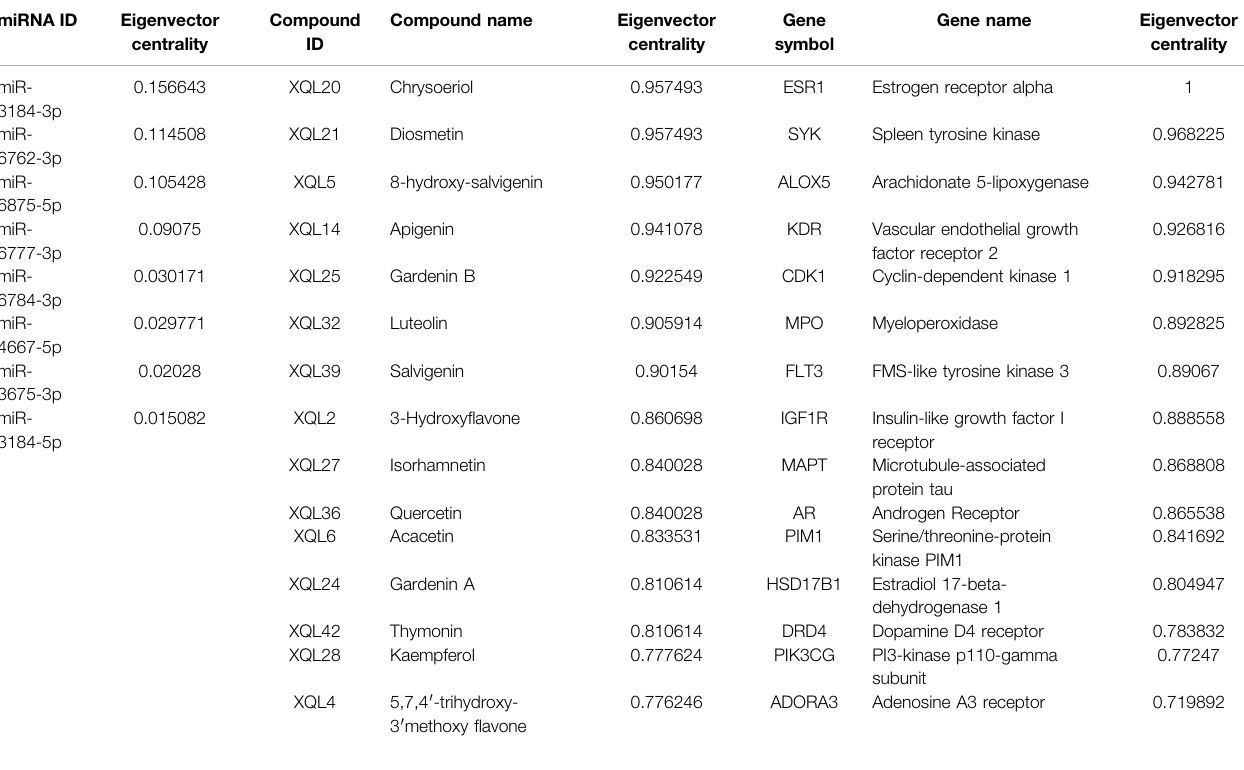
TABLE 5 | Correspondence of top 15 compounds, target genes, and miRNAs based on eigenvector centrality within the predicted compound-mRNA-miRNA network of total fl avonoids from Dracocephalum moldavica L. (TFDM). miRNA